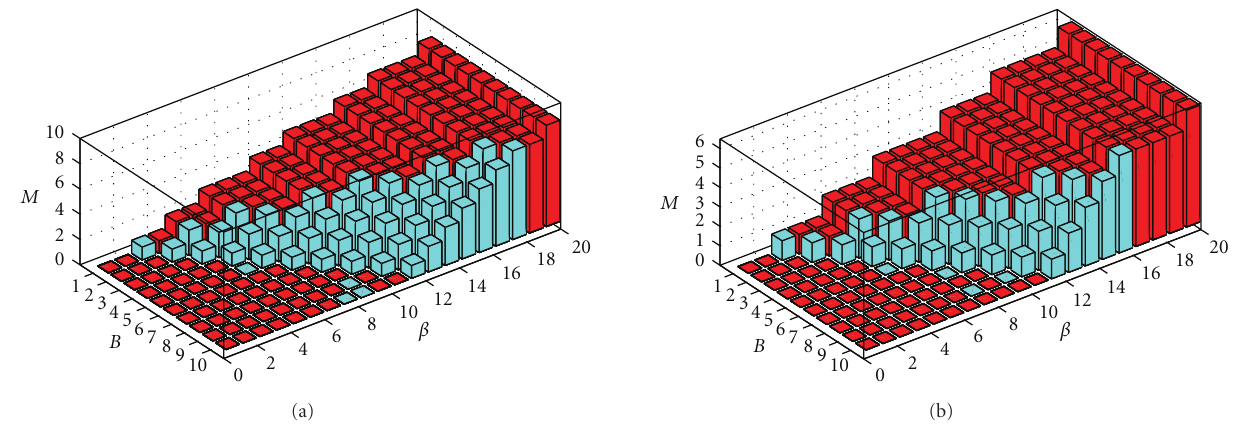
Figure 3: The maximum FEC group size ( M ) versus bu ff er fullness ( B ) and β for (a) α = 1.5 and (b) α =